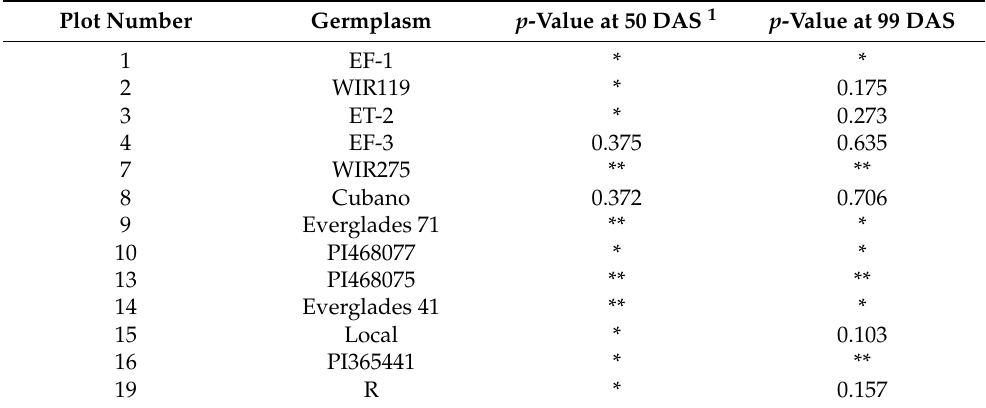
Table 1. The results of Kruskal–Wallis test among the replications. All plots in this table are in the high-growth region (red dot polygon in Figure 1).